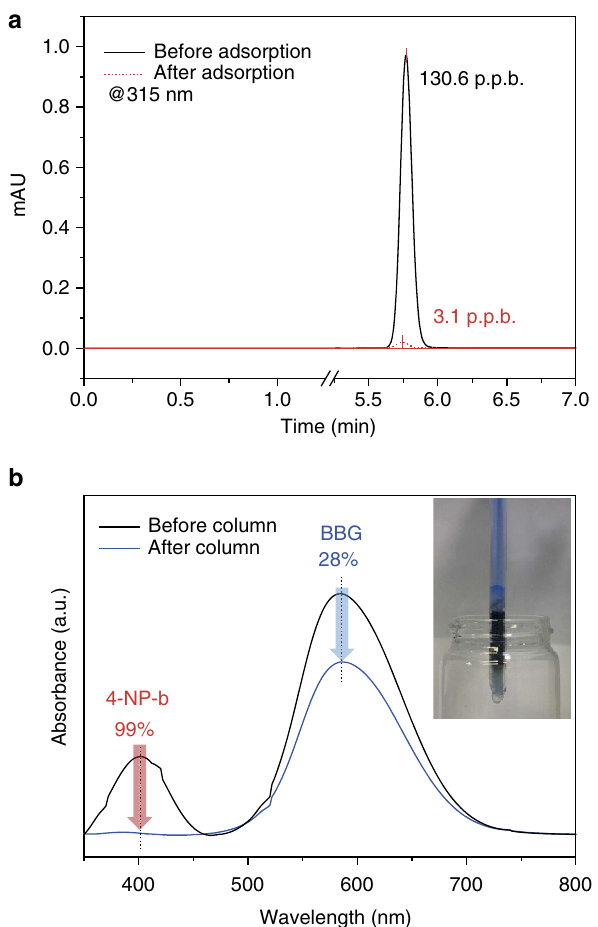
Figure 7 | Feasibility test of COP-99. ( a ) LC spectra of 4-NP-a before and after the treatment with COP-99. ( b ) ultraviolet–visible spectra of mixed dye solution before and after passing through a packed column of COP-99. The initial dye mixture was prepared in a 1:1 v/v ratio of 50 m M BBG and 30 m M 4-NP-b. Inset displays the photograph of the actual column tested in the